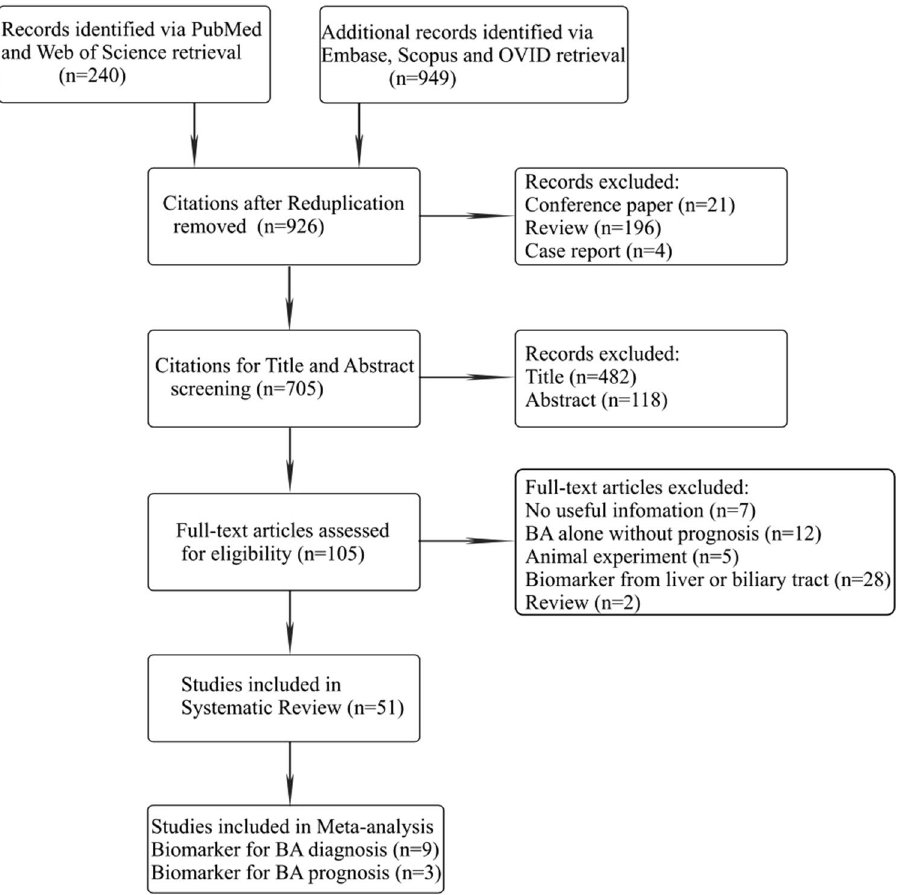
Figure 1. Flow diagram of study selection. Abbreviations: BA, biliary